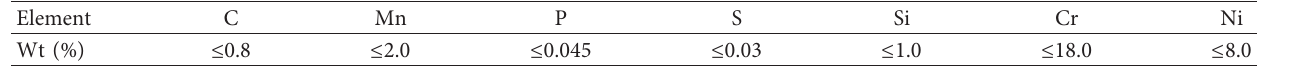
Table 1: Chemical composition of 304 stainless steel.